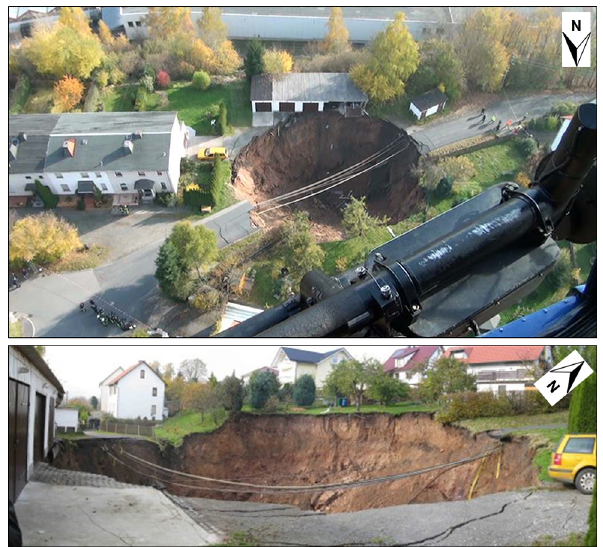
Figure 2. Photographs showing the sinkhole in Schmalkalden that opened up on 1 November 2010. It is 26 to 30m in diameter and 12 to 17m in depth (TLUG,